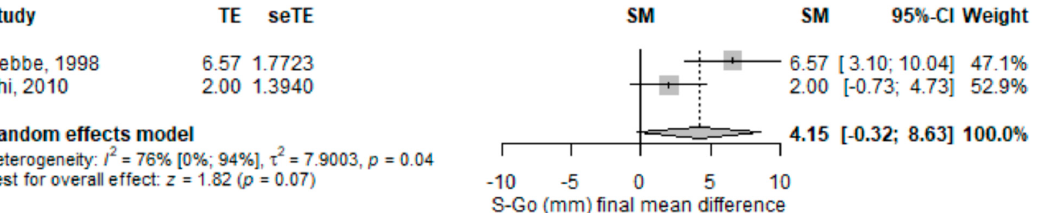
Figure 7. Forest plot for distance from sella to gonion (mm) standardized mean change difference. S ‐ Go—distance from sella to gonion; TE TE—effect; seTE—effect’s standard error; SM—the average discrepancy; CI—confidence interval.